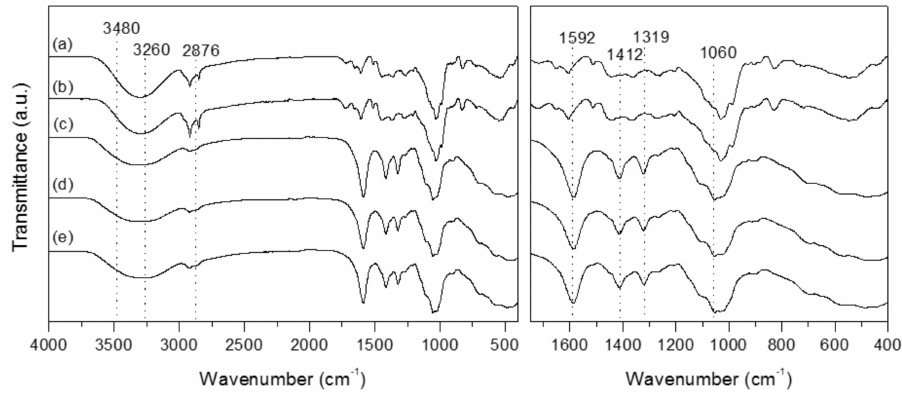
Figure 1. Full (left) and magnified (right) Attenuated Total Reflectance Infrared Spectroscopy (ATR-IR )spectra of BEO samples and prepared films with di ff erent BEO concentrations. ( a ) E-BEO; ( b ) M-BEO; ( c ) carboxymethyl cellulose (CMC) film (control); ( d ) 15E-BEO film; ( e ) 30M-BEO film.